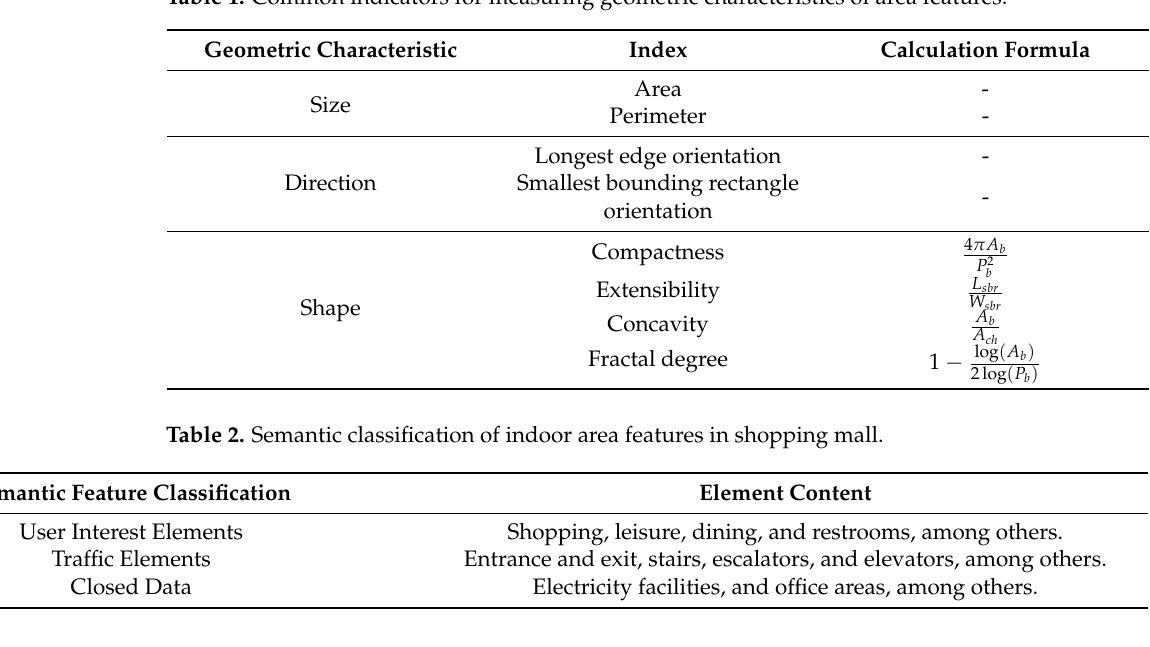
Table 1. Common indicators for measuring geometric characteristics of area features.